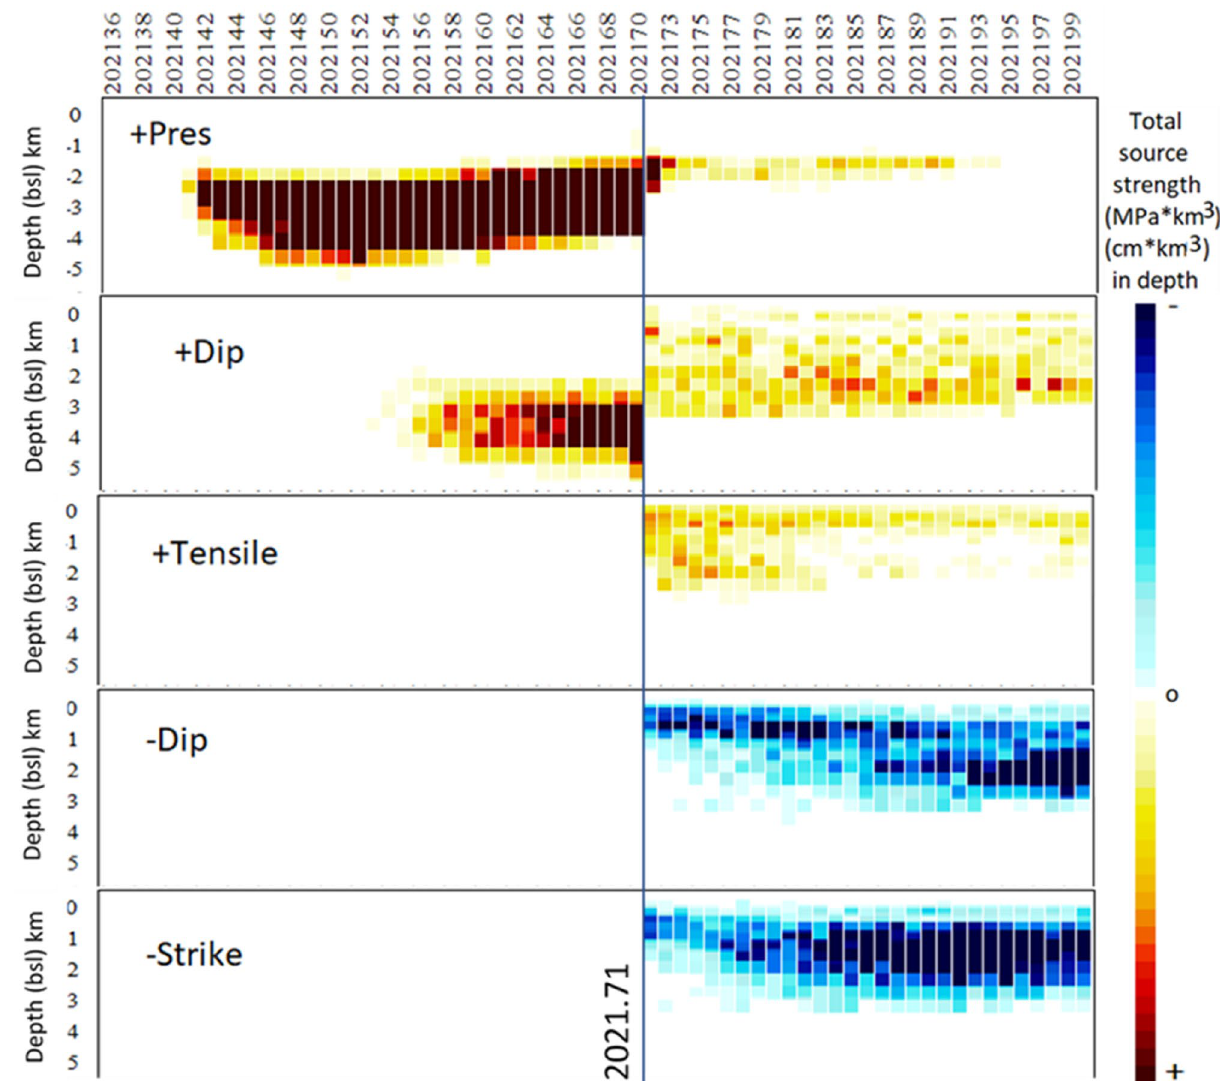
dark blue) for increasing negative values. Pressure strength values range between ± 20 MPa·km 3 each km in depth, dislocation strength values range between ± 50 cm·km 3 each km in depth. Two precursor phenomena are clearly distinguished: (1) the intrusive pressure increase from 2021.40 (05/26/2021), and (2) the ascending mass dip from 2021.55 (20/07/2021). Matlab software (www. mathw orks. com) was used to create this